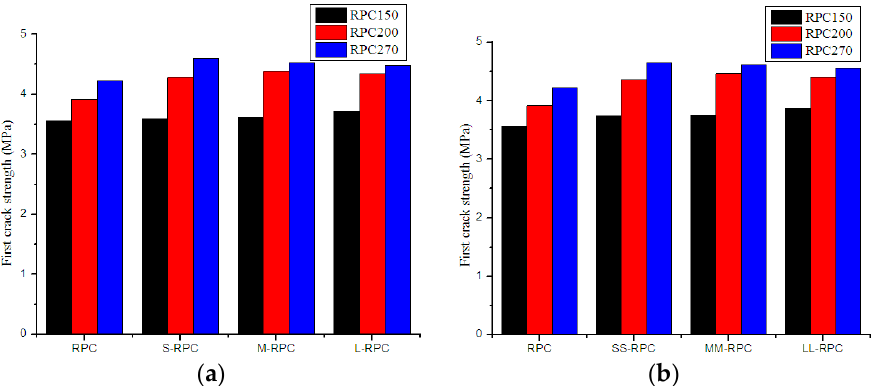
Figure 6. Effects of steel fiber length on first-crack strength of RPC: ( a ) 0.5% fiber content and ( b ) 2.0% fiber content.